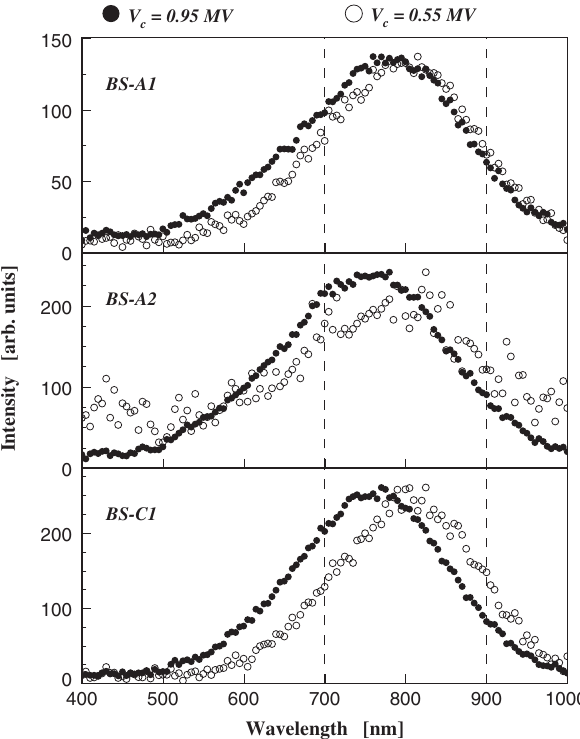
FIG. 16. Observed spectra of the stable bright spots BS-A1, BS-A2, and BS-C1 after applying the pixel sensitivity and wavelength calibrations, the mirror chamber correction, and background subtraction. The vertical dashed lines indicate the region in which the physical spectra were derived.